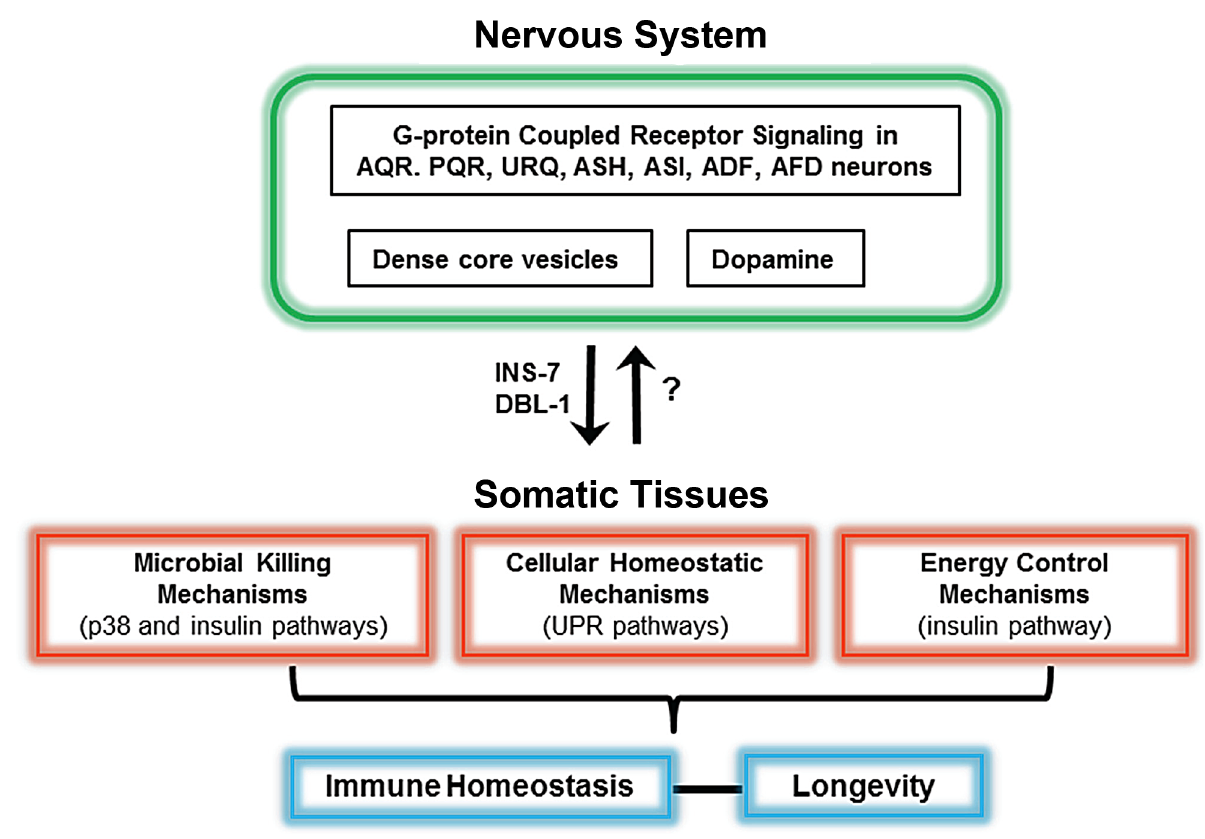
Figure 1. Schematic of the neural control of different pathways required for immunity in C.elegans . At least seven neurons in the nervous system control microbial killing pathways and cellular homeostatic pathways. In addition to AQR, PQR, URX, ASH, and ASI neurons, dopaminergic neurons also control the p38 MAPK pathway. While ASH and ASI control the unfolded protein response (UPR), ADF and AFD control both the UPR and the insulin pathway. Neurally produced INS-7 and DBL-1 target somatic tissues to control immunity. A fine-tuned control of protein homeostasis and metabolism by the nervous system seems to be important to maintain immune homeostasis.